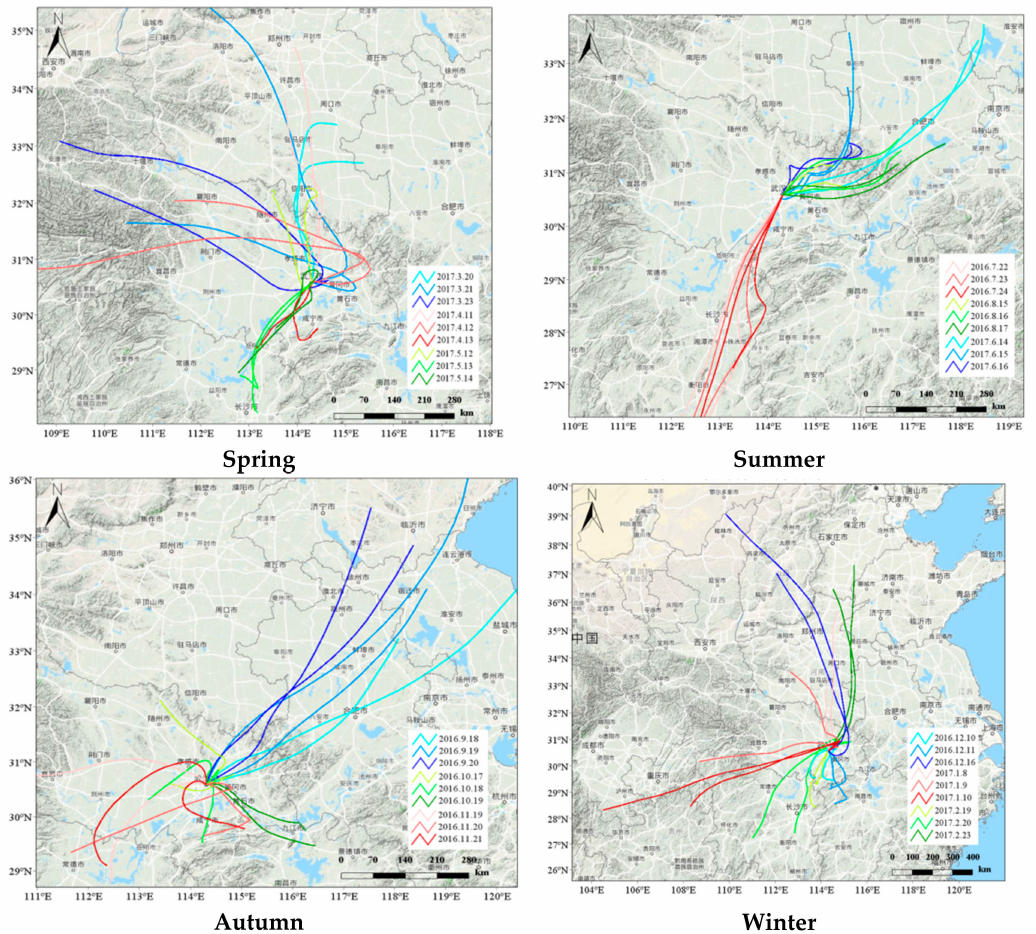
Figure 4. Analytical results of the 72 h air mass back trajectories at 500 m elevation during the monitoring periods, at 9:00 and 15:00 during the sampling